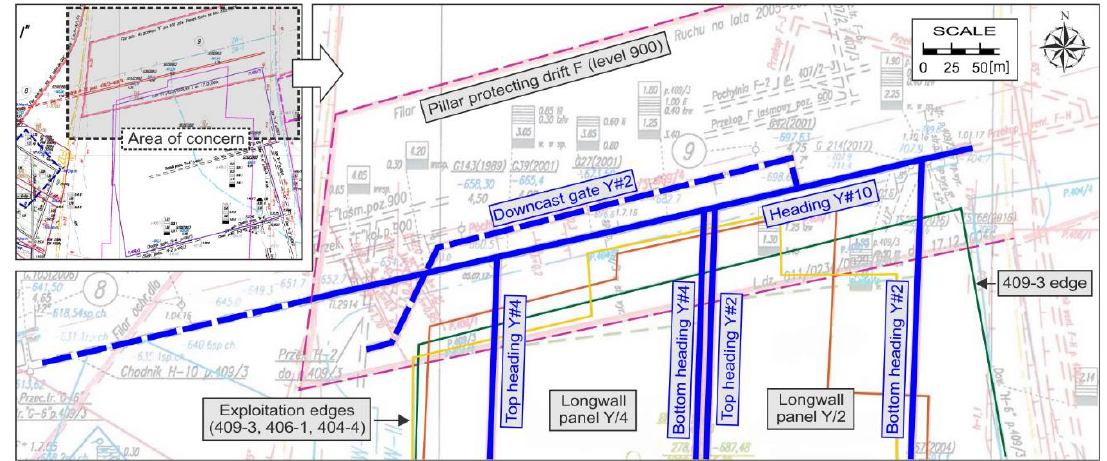
Figure 1. Coal seam section in the area of concern.